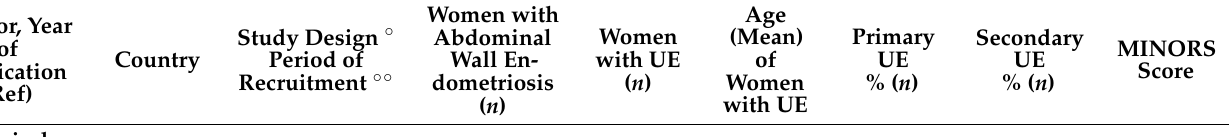
Table 1. Main characteristics of the selected